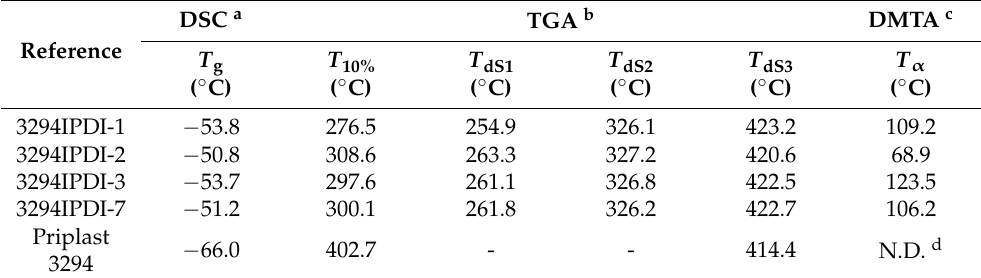
Figure 8. DDSC thermograms of Priplast 3294 and WPUD films. Glass-transition temperatures has been calculated taken as the inflection point of the heating step scan DSC. Table 5. Thermal properties of WPUD films evaluated by DSC, TGA, and